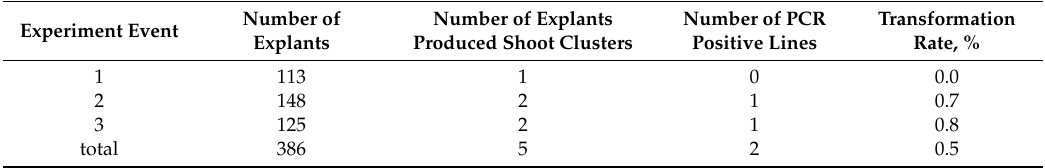
PCR: polymerase chain